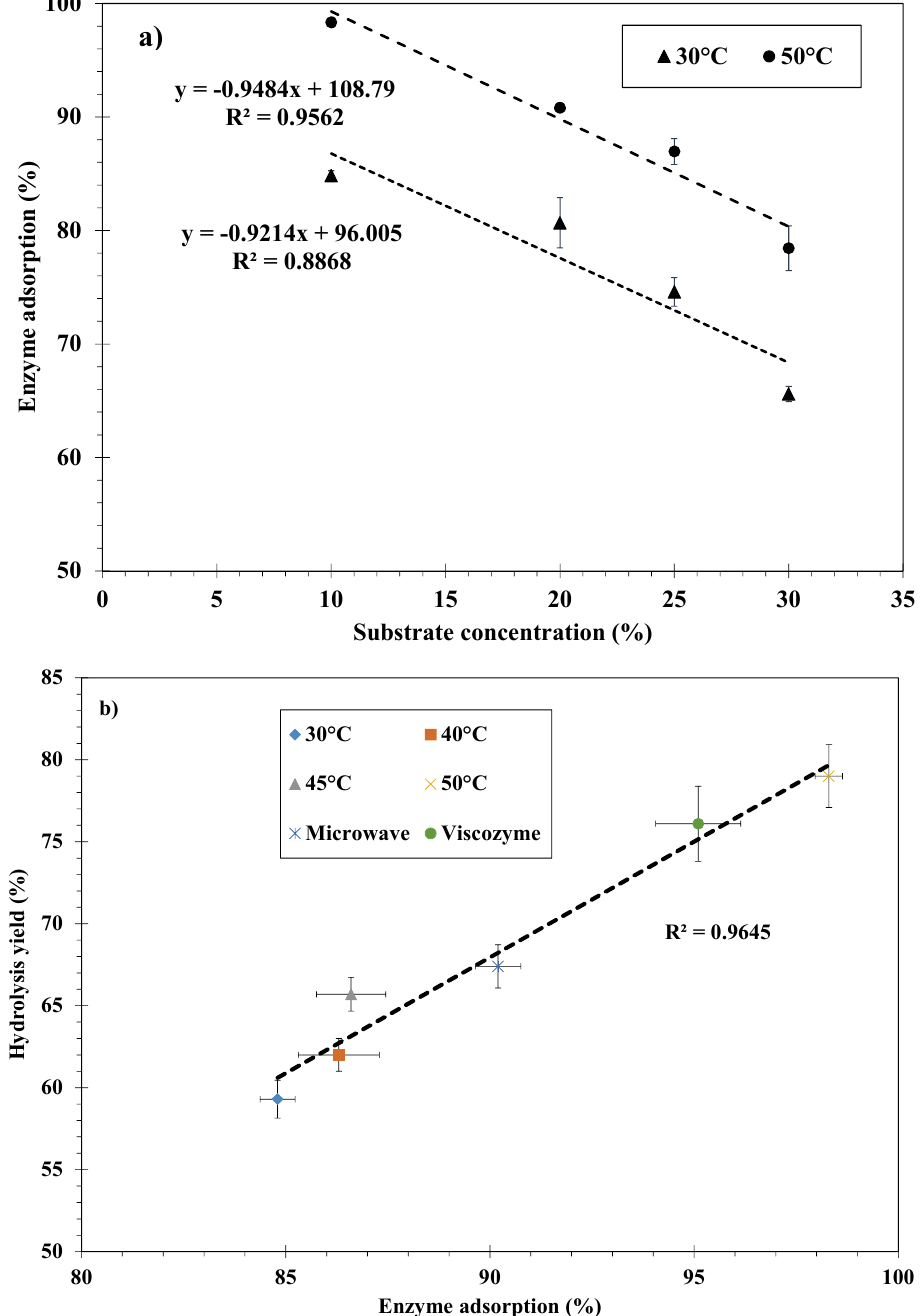
Figure 3. ( a ) Impact of substrate concentration on enzyme adsorption. ( b ) Correlation between enzyme adsorption and hydrolysis yield (10% of starch).